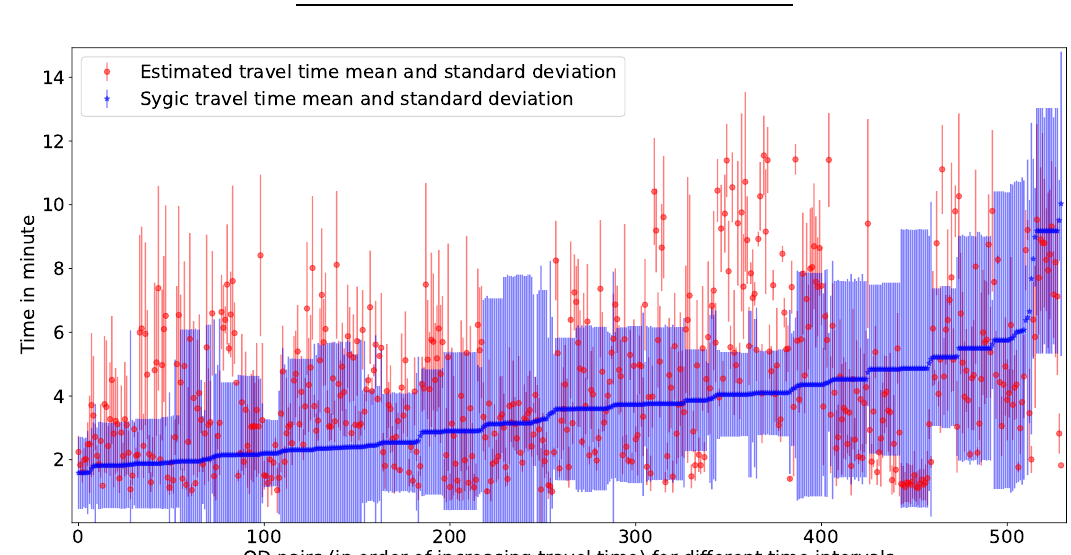
OD pairs (in order of increasing travel time) for different time intervals Figure 16. Estimated travel time validated with Sygic data (for Q1 of the year